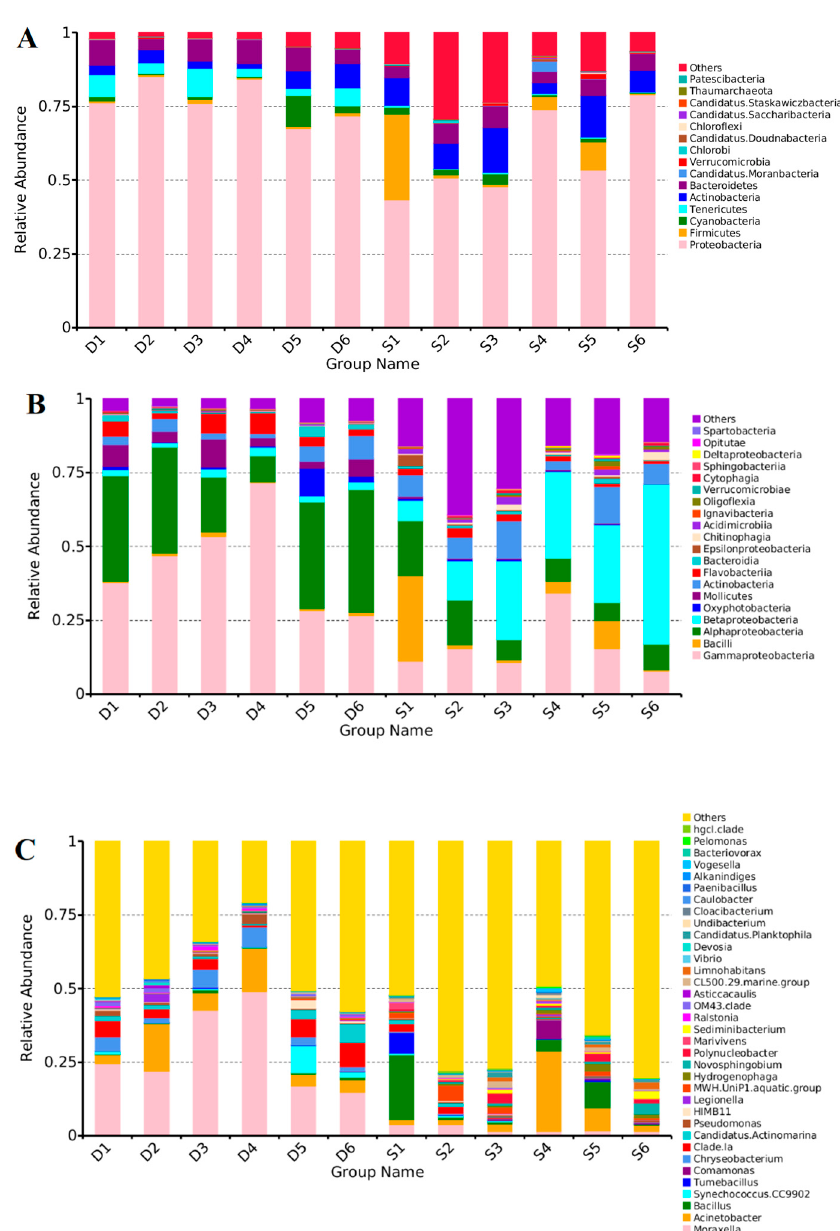
Figure 2. Bacterial community compositions of all samples at phylum ( A ), class ( B ), and genus ( C ) levels (based on relative abundance). Top 15 phyla, top 20 classes, and top 35 genera are presented in the figures, and others represent the sum of the rest phyla, classes and genera, respectively. Three samples at the same site are shown on average.